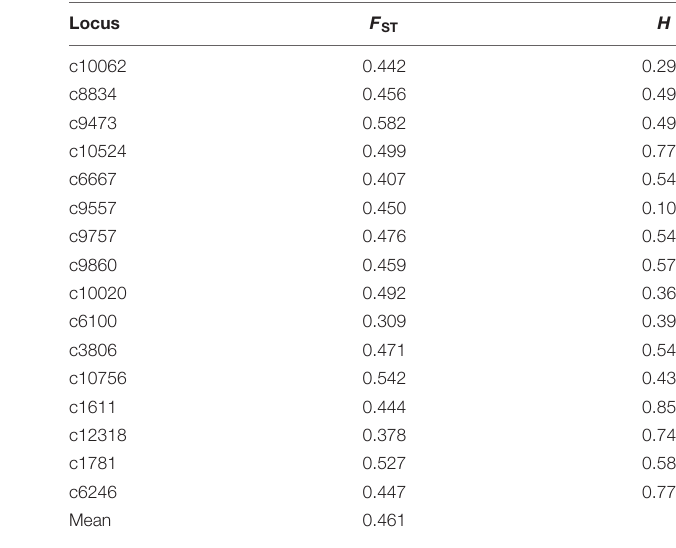
TABLE 5 | Summary of index population differentiation ( F ST ) and heterozygosity ( H ) from each locus in Alternaria tenuissima isolates collected from China.